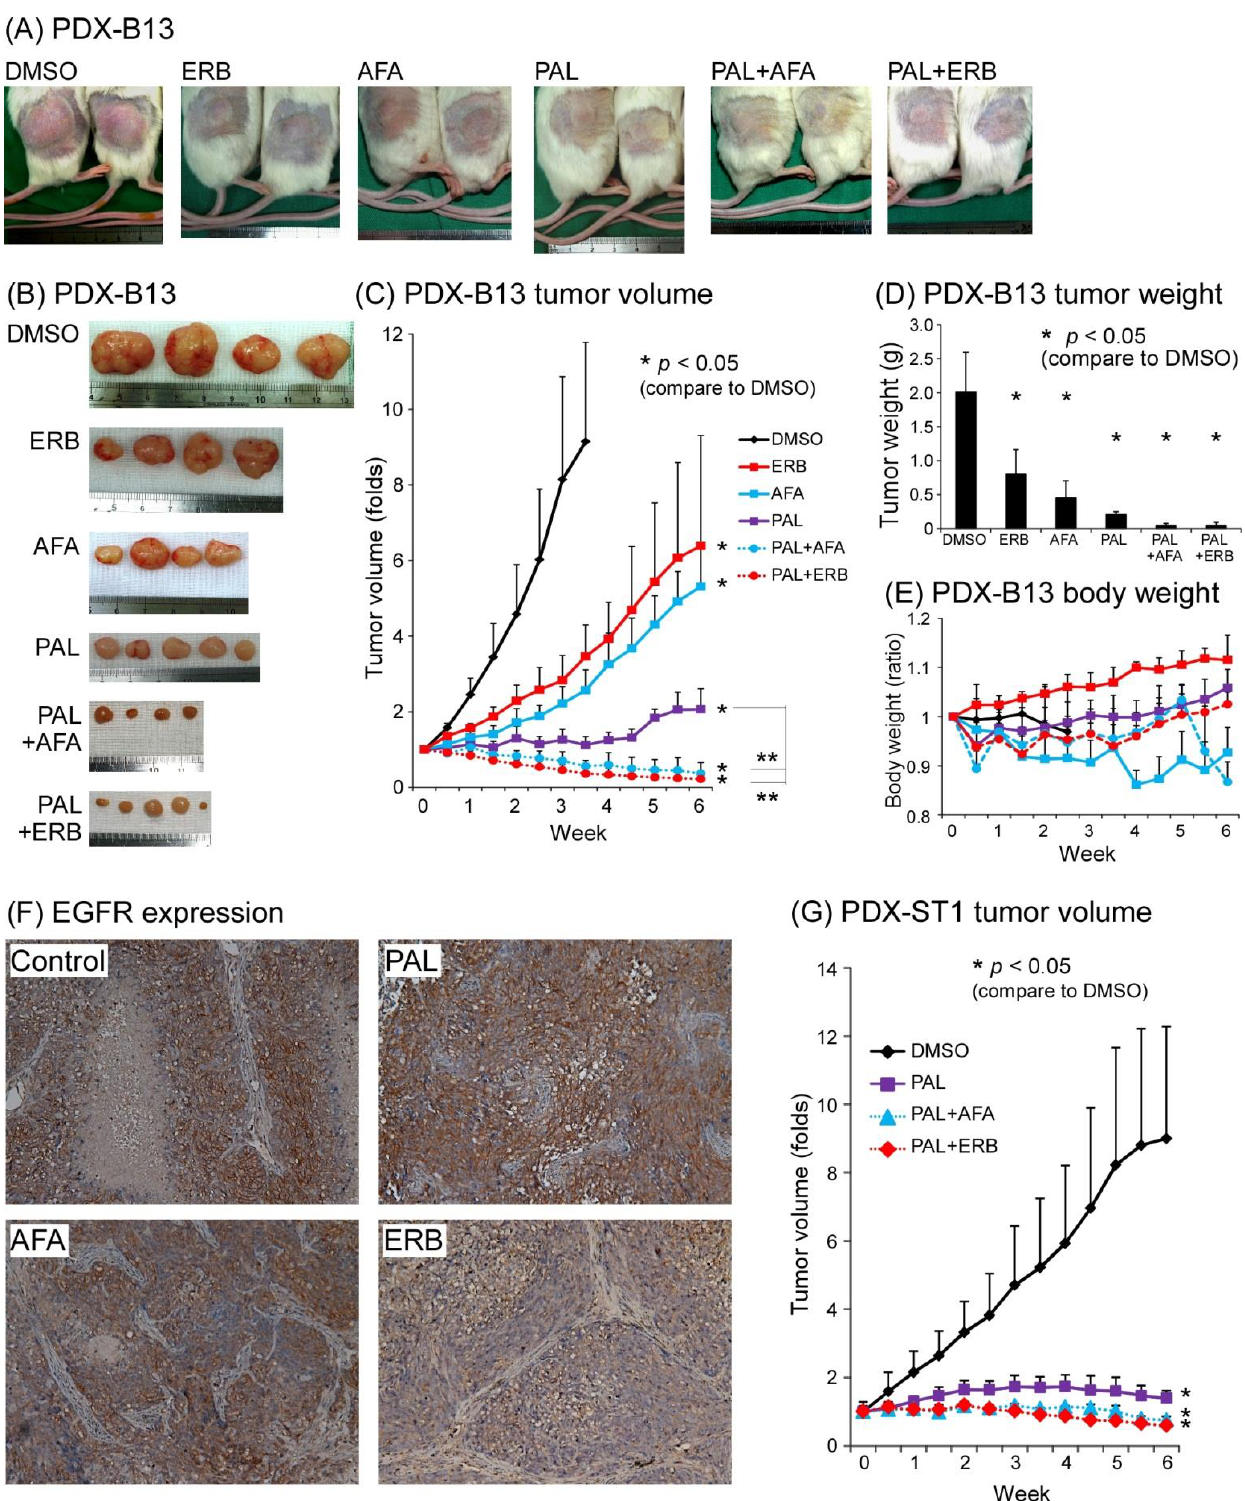
Figure 3. NPC PDX drug screening. PDX-B13, NPC PDX-B13F11; PDX-ST1, NPC PDX-ST1F15. ( A , B ) Mouse gross tumor, ( C ) tumor volume, ( D ) tumor weight, and ( E ) body weight change. ( F ) EGFR expression before (Control) and after treatment (PAL, AFA, and ERB) (200×) ( G ) NPC PDX-ST1 drug screening. ** p < 0.01. Abbreviations: AFA: afatinib; ERB: erbitux; PAL: palbociclib.